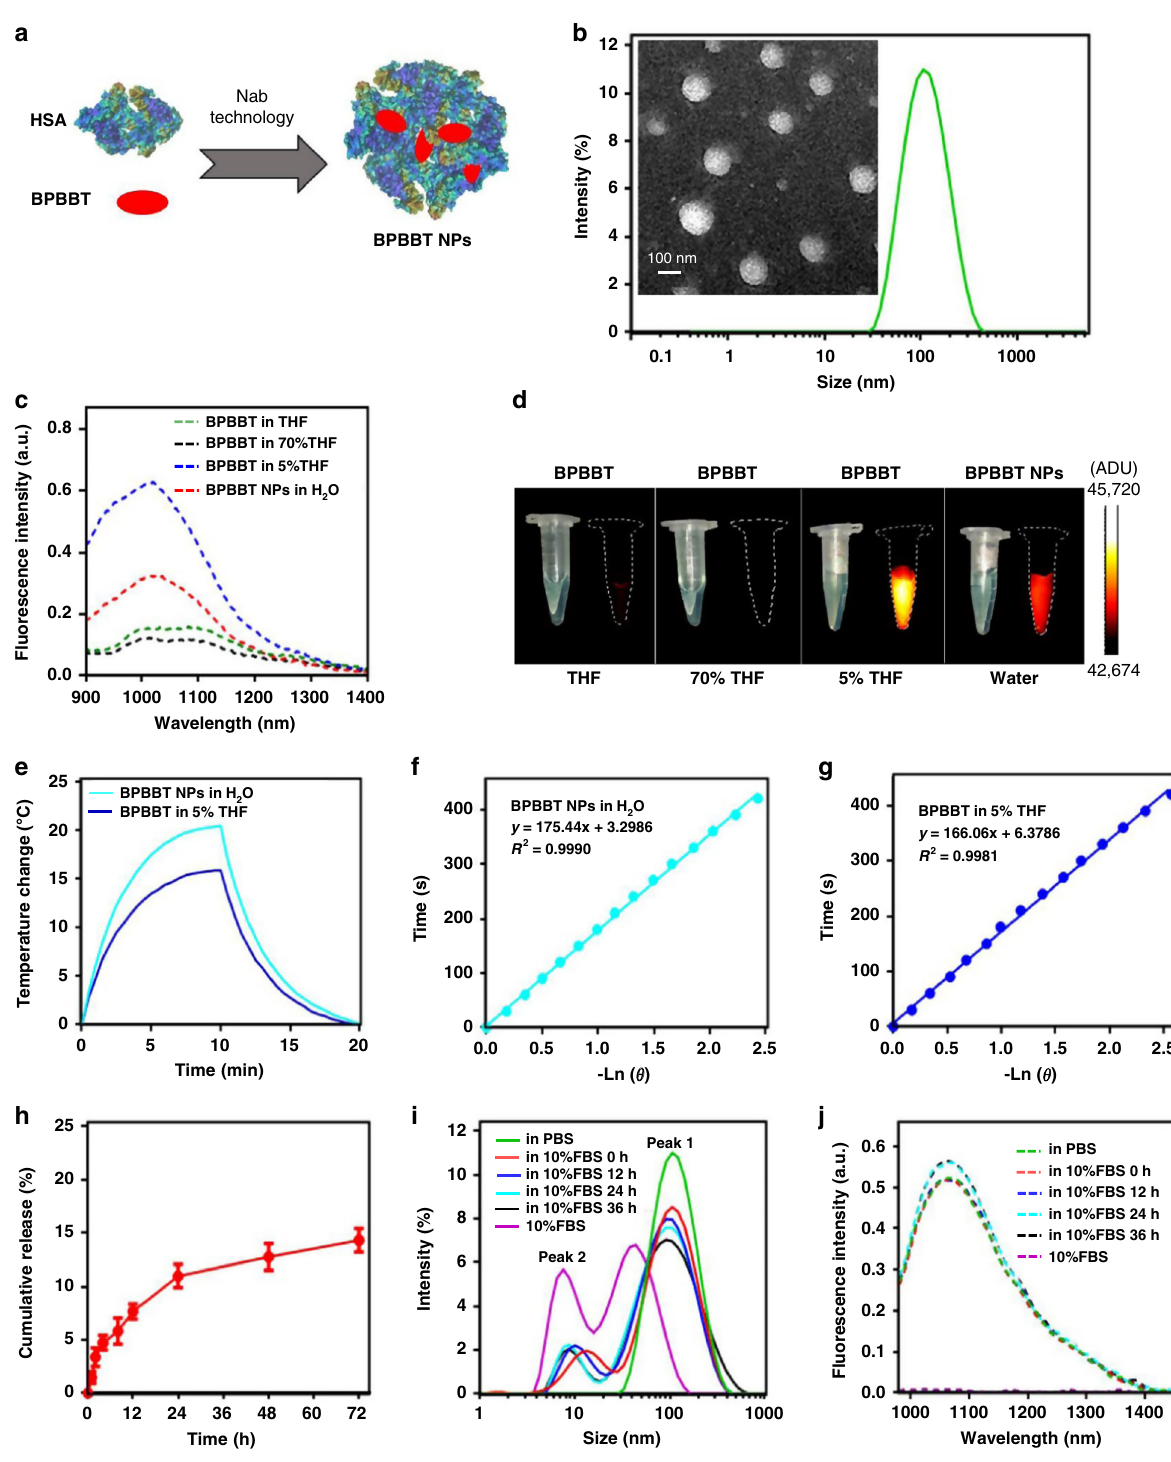
Fig. 4 Characterization of BPBBT NPs. a Schematic illustration of BPBBT NPs. b Representative TEM image and size distribution of BPBBT NPs. c Fluorescence emission spectra of BPBBT (10 µ M) in THF, 70% THF, 5% THF or BPBBT NPs (10 µ M of BPBBT) in water excited at 831 nm. d Photographs and NIR-II fl uorescence images of the solutions in ( c ). e Temperature-time curves of BPBBT NPs (50 µ M of BPBBT) in water or BPBBT (50 µ M) in 95% water:5% THF under the laser irradiation (808 nm, 1 W cm − 2 ) for initial 10 min, followed by 10 min of cooling. f , g Time constant for heat transfer from the system of BPBBT NPs or BPBBT in 95% water:5% THF is determined to be τ s = 175 s or 166 s by applying the linear time data from the cooling period versus negative natural logarithm of driving force temperature, which is obtained from the cooling stage of panel ( e ). h Release pro fi le of BPBBT from BPBBT NPs in 10% FBS. Data are presented as Mean ± S.D. ( n = 3). i Size distribution of 10% FBS, BPBBT NPs in PBS, or BPBBT NPs in 10% FBS at different time points following mixture. Peak 1 from the nanoparticles; Peak 2 from serum. j Fluorescence emission spectrum of 10% FBS, BPBBT NPs in PBS, or BPBBT NPs in 10% FBS for different incubation